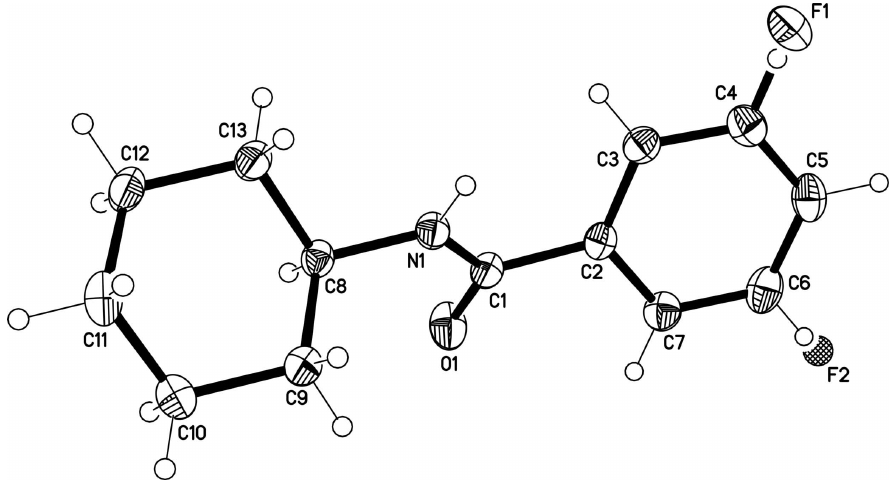
Figure 1 Molecular structure of title compound, showing the rotational disorder of the fluorophenyl ring. Displacement ellipsoids are drawn at the 50% probability